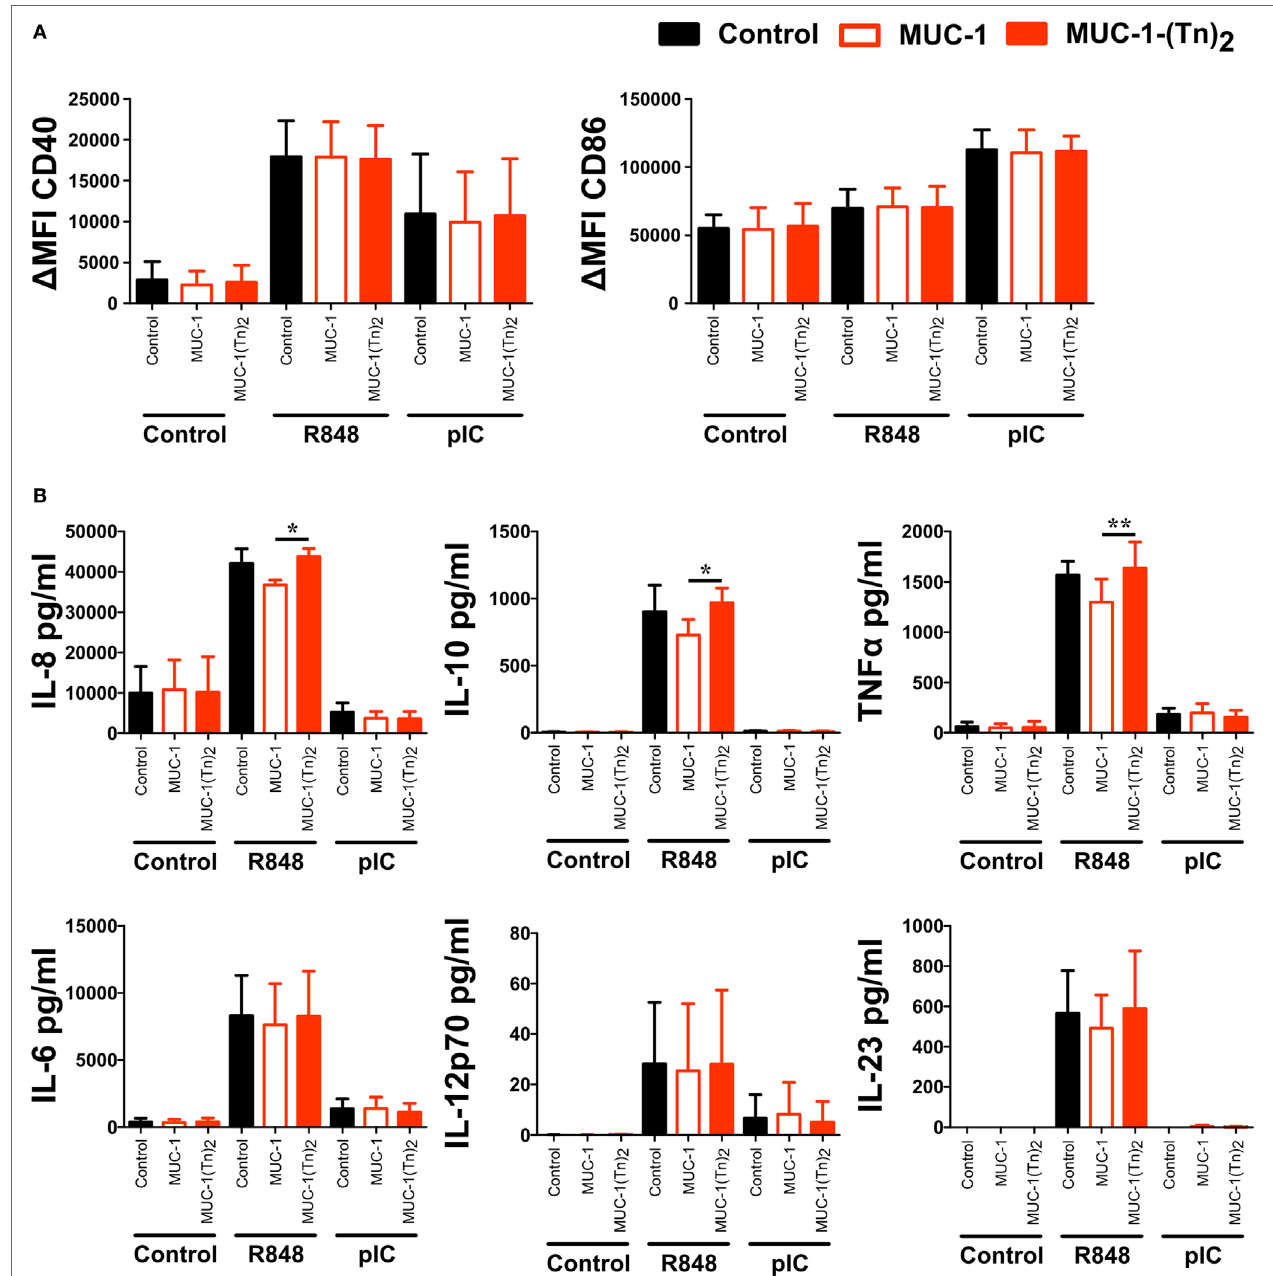
FigUre 6 | Stimulation of CD1c + dendritic cells (DCs) with MUC-1-(Tn) 2 enhances TLR-induced secretion of IL-8, IL-10, and TNF α . CD1c + DCs were sorted from PBMCs of healthy donors and stimulated with 10 µg/ml MUC-1-(Tn) 2 or MUC-1 in the presence of 5 µg/ml R848 or 5 µg/ml pIC or in medium alone. After 12 h of stimulation, (a) cells were analyzed for the expression of the co-stimulatory molecules CD40 and CD86 and (B) the supernatant analyzed for the secretion of the cytokines IL-8, IL-10, TNF α , IL-6, and IL-12p70 with the LEGENDplex Human Anti-Virus Response Panel (BioLegend). Bar graphs show (a) Δ MFI ± SD ( n = 4) and (B) mean ± SD ( n = 4). p values were calculated using GraphPad Prism (paired t -test; * p < 0.05 and ** p <